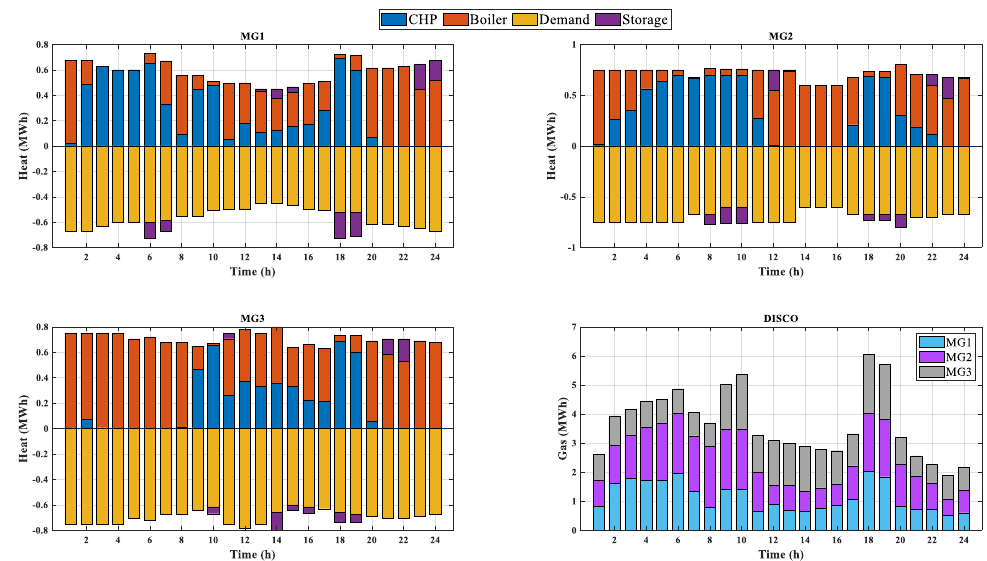
Figure 8. Optimal stochastic heat management of MGs and NG management of MGs and DISCO.